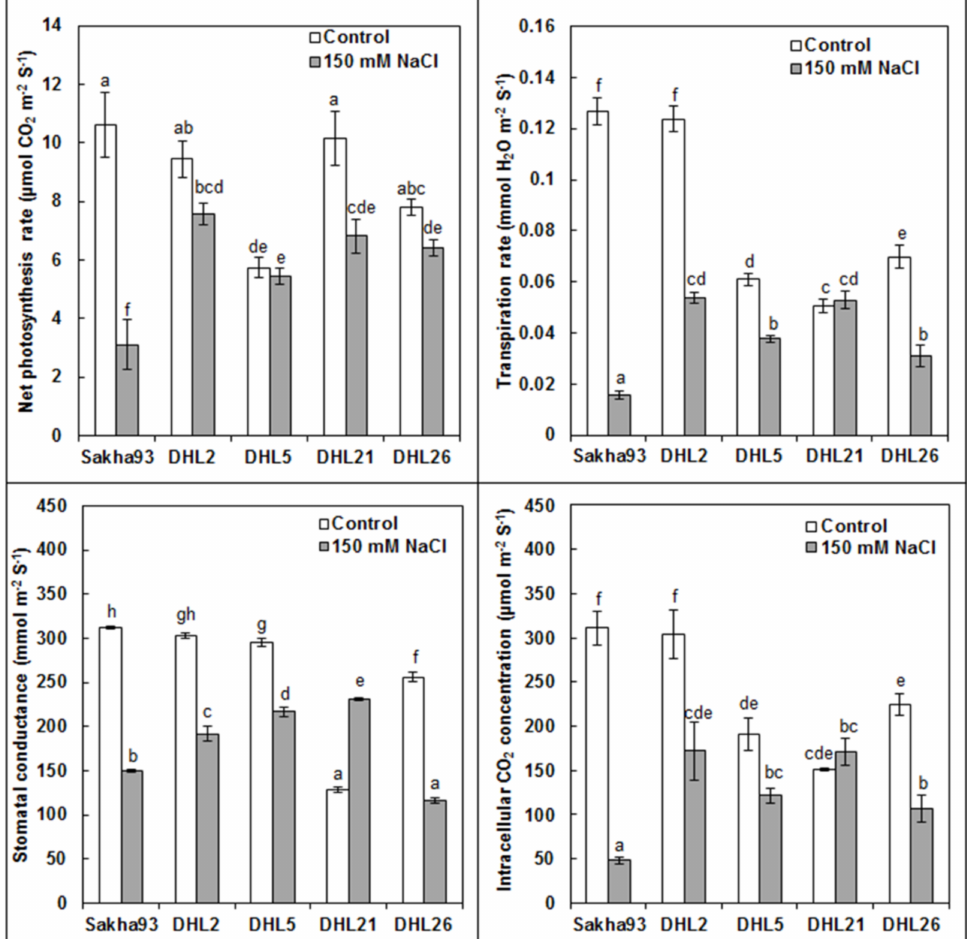
Figure 5. Evaluation of photosynthetic parameters in five wheat genotypes under normal and salt stress conditions. Values are presented as the mean ± SE of at least three replications, and values sharing the same letter for each treatment × genotype combination are not significantly different ( p ≤ 0.05) according to Duncan’s multiple range